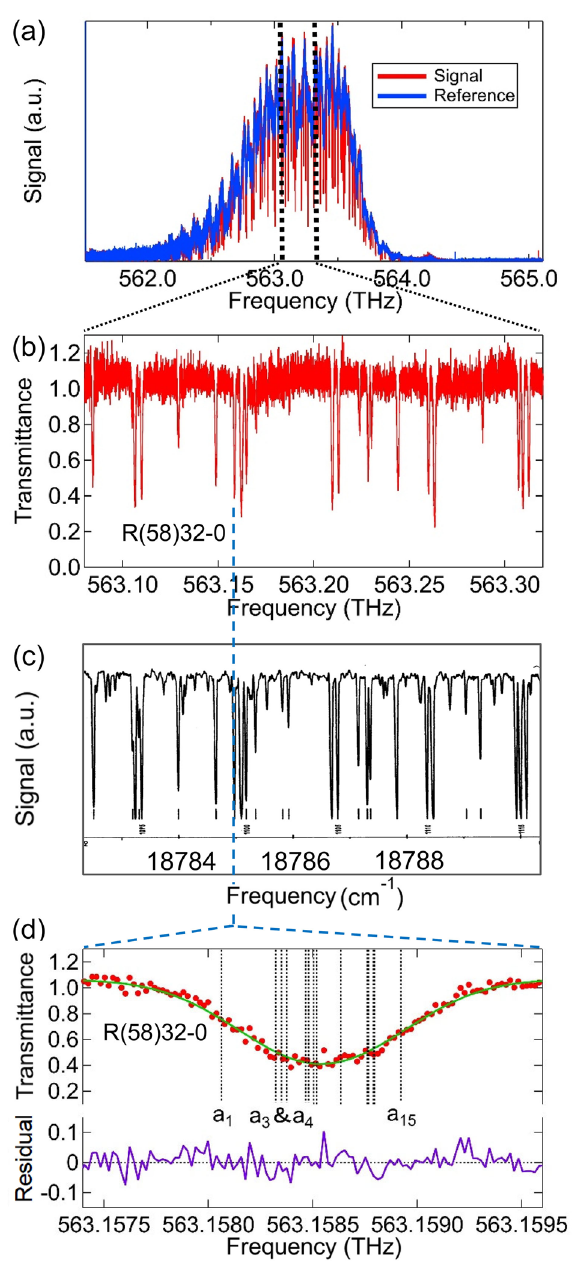
Figure 4. ( a ) Observed signal and reference spectra using DCS. The signal spectrum contains the absorption lines of 127 I 2 , whereas the reference spectrum contains only background spectrum of the dual comb spectrometer without the gas sample of 127 I 2 . ( b ) Normalized spectra obtained ( a ) in an enlarged frequency range of 563.08–563.32 THz. ( c ) Iodine spectra obtained using Fourier transform infrared spectroscopy 26 , which is shown here for comparison. The full range of the horizontal axis (18,782.3–18,790.3 cm − 1 ) is equivalent to ( b ). ( d ) Enlarged view of the R(58)32-0 line (red solid circles) and the theoretical fit (green curve) by overlapping the Gauss profiles of 15 hyperfine components (shown as vertical lines). Fitting residual (purple curve) is also